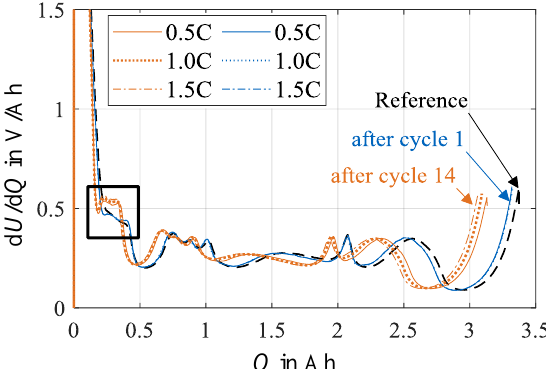
Figure 8. Overview of the absolute DVA spectra at test points with charge rates of 0.5C, 1.0C and 1.5C after load cycles 1 and 14 at 0 °C.